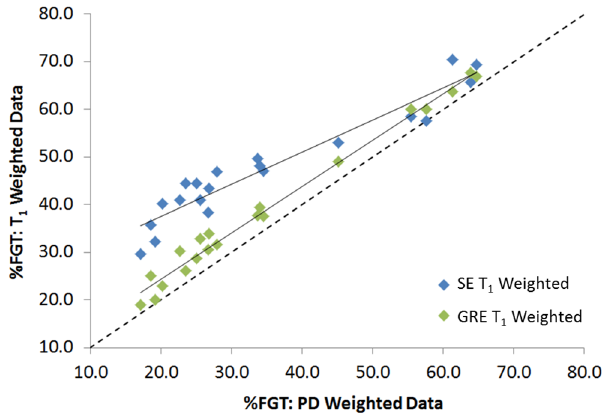
Fig 4. Correlation between low resolution %FGT measurements from GRE and SE T 1 -weighted data vs . GRE PD-weighted data.